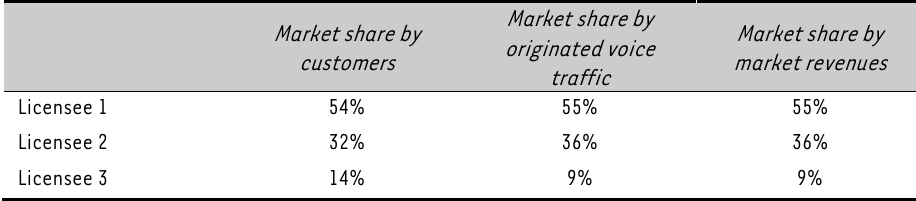
TABLE 1: Retail mobile market shares, by total customer connections, originated voice minutes, and revenues, as at June 2009 Market share by Market share by Market share by originated voice customers market traffic